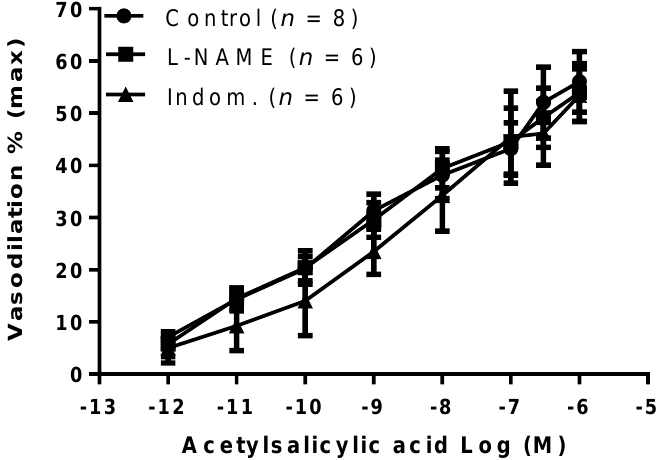
Figure 3. Effect of acetylsalicylic acid in the presence of nitric oxide synthase and cyclooxygenase Figure 3 . Effect of acetylsalicylic acid in the presence of nitric oxide synthase and cyclooxygenase inhibitors. Acetylsalicylic acid was tested on phenylephrine preconstricted mesenteric arteries inhibitors. Acetylsalicylic acid was tested on phenylephrine preconstricted mesenteric arteries iso- isolated from gravid rats in the absence (Control) and in the presence of inhibitors of either nitric lated from gravid rats in the absence (Control) and in the presence of inhibitors of either nitric oxide oxide synthase (L-NAME, 2 × 10 − 4 M), or cyclooxygenase (Indom., 10 − 5 M). Data are reported as synthase (L-NAME, 2x10 −4 M), or cyclooxygenase (Indom., 10 −5 M). Data are reported as mean ± mean ± SEM, n = number of experiments. Figure 3 . Effect of acetylsalicylic acid in the presence of nitric oxide synthase and cyclooxygenase SEM, n = number of experiments. inhibitors. Acetylsalicylic acid was tested on phenylephrine preconstricted mesenteric arteries iso- To find out if the EDHF was involved in aspirin vasodilation, MA were precon- lated from gravid rats in the absence (Control) and in the presence of inhibitors of either nitric oxide stricted with high KCl (80mM), which completely abolished the vasodilator effect of aspirin synthase (L-NAME, 2x10 −4 M), or cyclooxygenase (Indom., 10 −5 M). Data are reported as mean ± ( p < 0.001, Figure SEM, n = number of experiments.